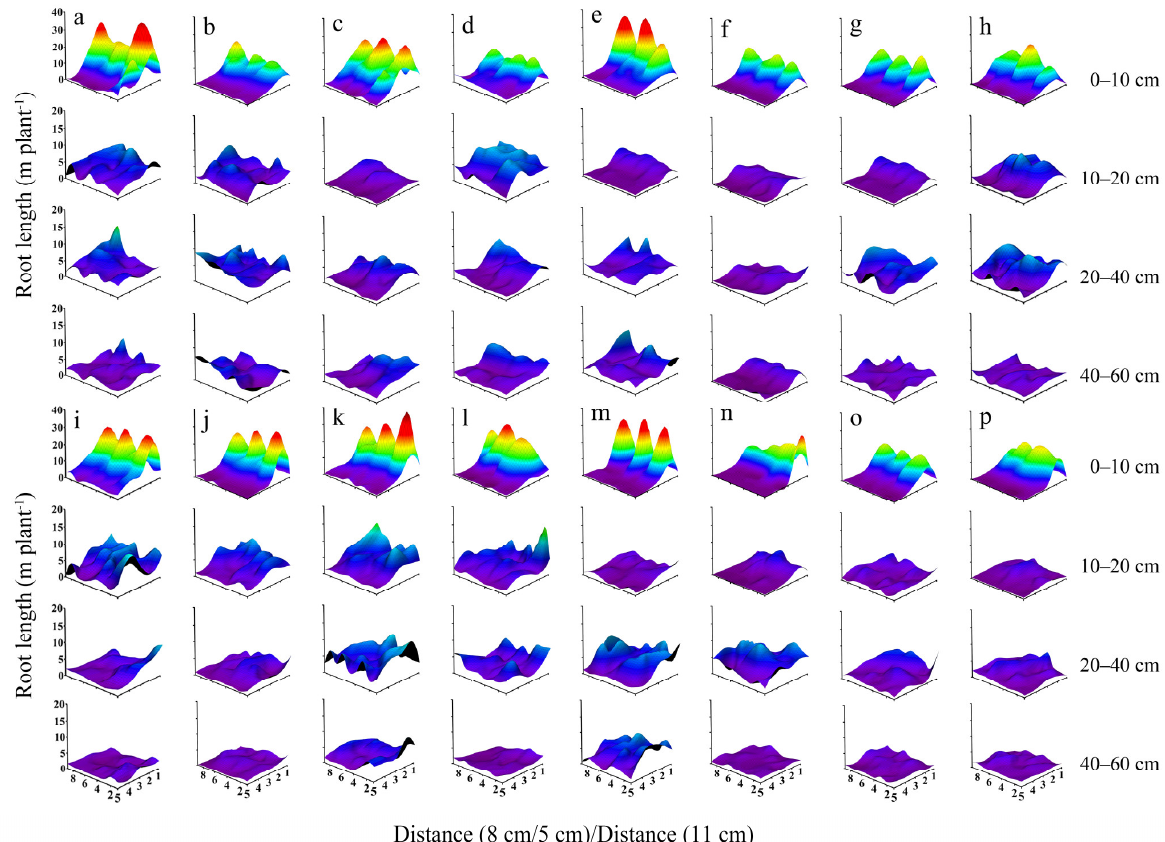
Figure 4. Vertical distribution of root length (RL) for two maize cultivars (DH618 and SC704) grown at two planting densities (D1 and D2). ( a – d ) RL at the silking stage in 2019 for ( a ) DH618